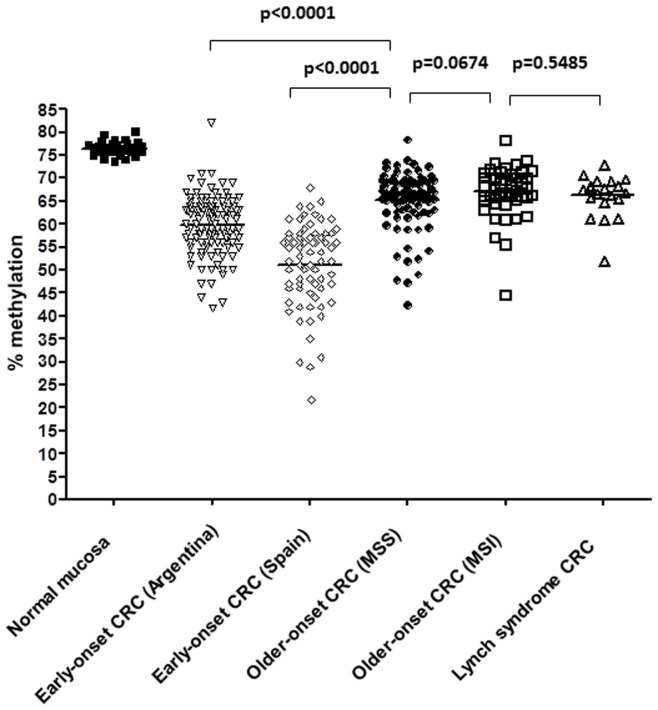
LINE-1 methylation analysis by bisulfite pyrosequencing in different CRC subsets.Bisulfite pyrosequencing of LINE-1 in colorectal tissues; Normal mucosa (n = 32), early-onset CRC from Argentina (n = 116), early-onset CRC from Spain (n = 70), older onset CRC with microsatellite stability (MSS; n = 89), older onset CRC with microsatellite instability (MSI) associated with MLH1 promoter hypermethylation (n = 46) and Lynch syndrome CRCs (n = 20).The black horizontal bar indicates the mean methylation level.